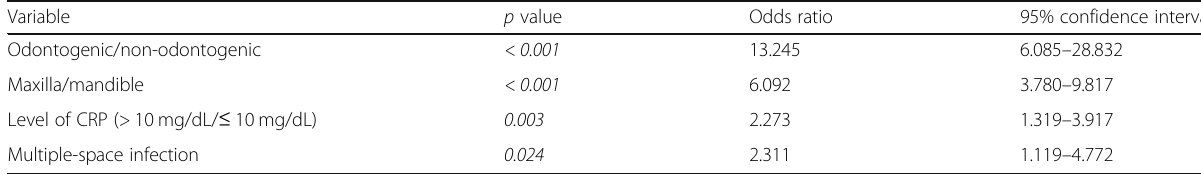
Table 3 Patient characteristics and admission: multivariable analysis Variable p value Odds ratio